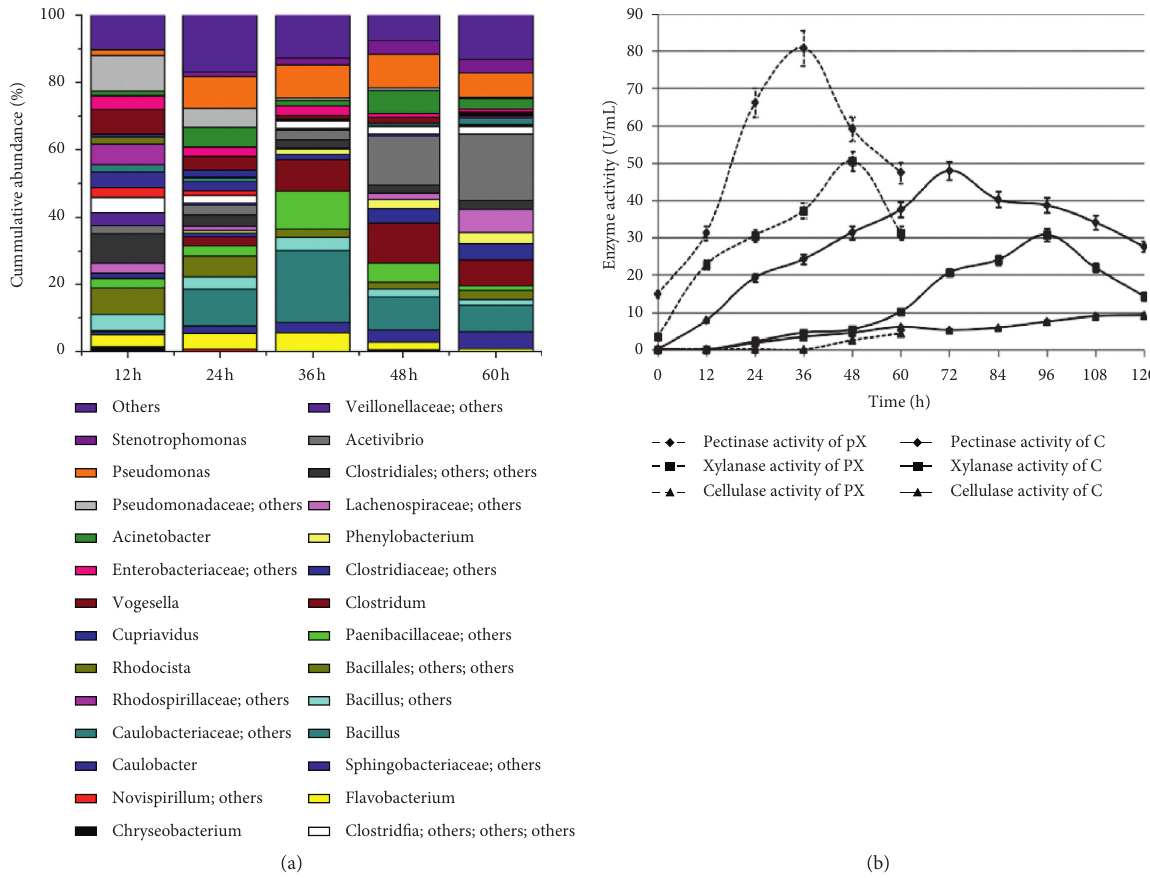
Figure 13: (a) The changes in bacterial composition during bioaugmentation retting throughout 60hours and (b) enzyme activity levels (U/ mL) of water retting, C and P05/X12 microbe retting, PX during bioaugmentation retting